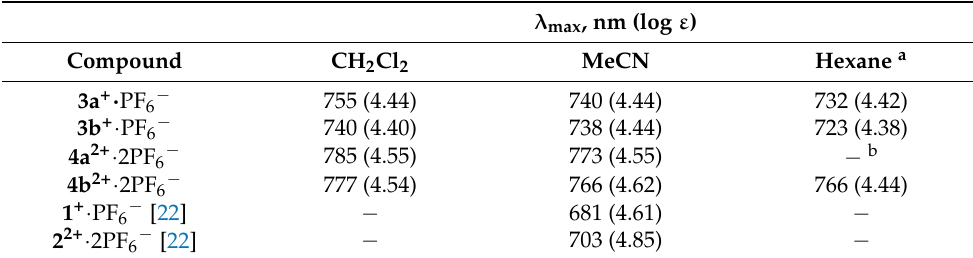
could not be determined since the absorption band was broadened into the near-infrared region.